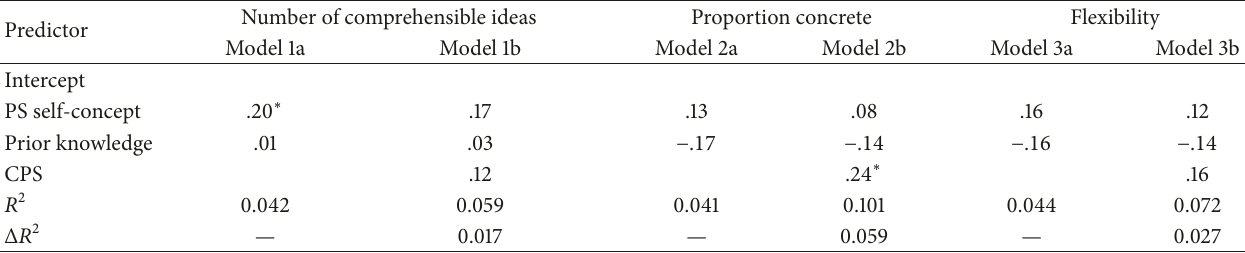
Table 3: Regression analyses with (1) the number of comprehensible ideas, (2) the proportion of concrete ideas of comprehensible ideas, and (3) flexibility as dependent